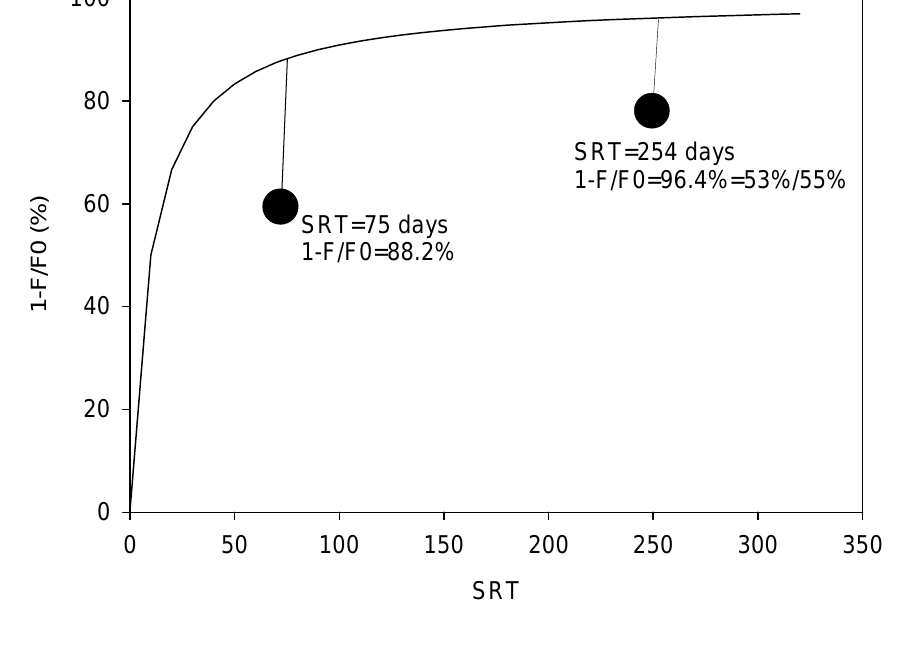
Figure 6. Stabilisation of the sludge represented by 1-F/F0 as a function of the SRT is 0.1 d -1 ). (equation 6, hypothetical, k h